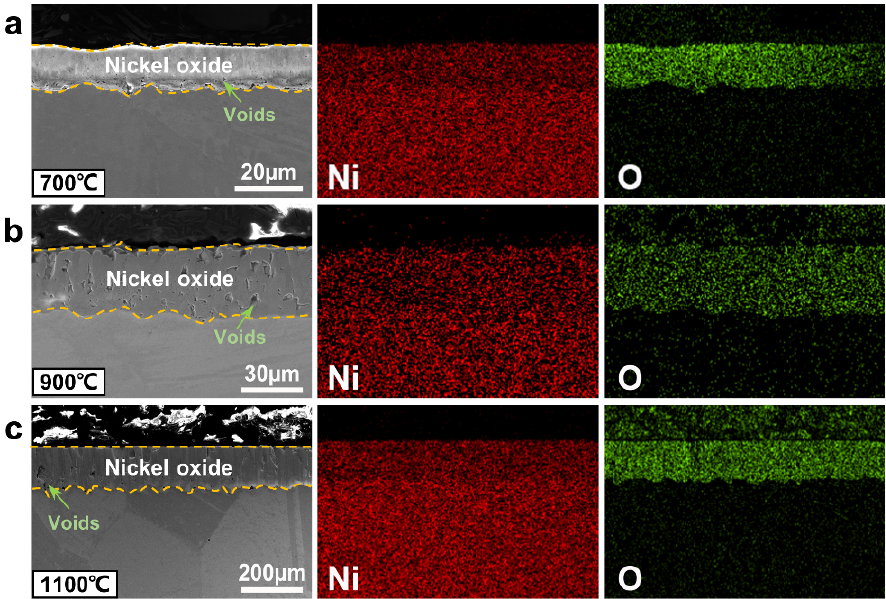
Figure 3. Cross-sectional microstructures (SE images) and corresponding EDS maps of oxide scales formed on Ni oxidized at ( a ) 700 °C, ( b ) 900 °C, and ( c ) 1100 °C for 576 h. Note that Ni forms a monolayer nickel oxide.